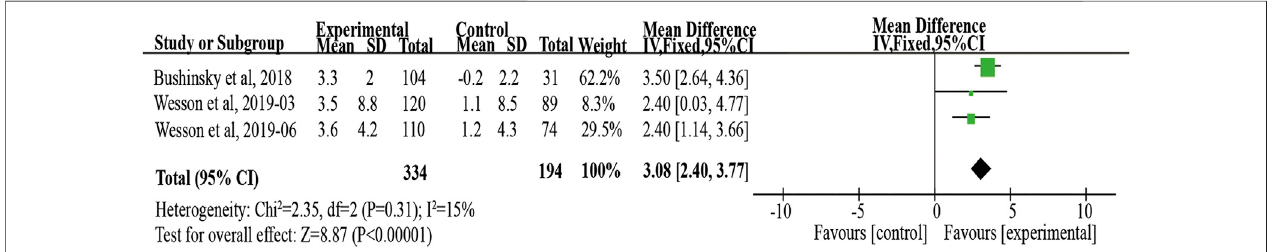
FIGURE 3 | Forest plot for change in serum bicarbonate. IV, independent variable method; 95% CI, 95% con fi dence interval.